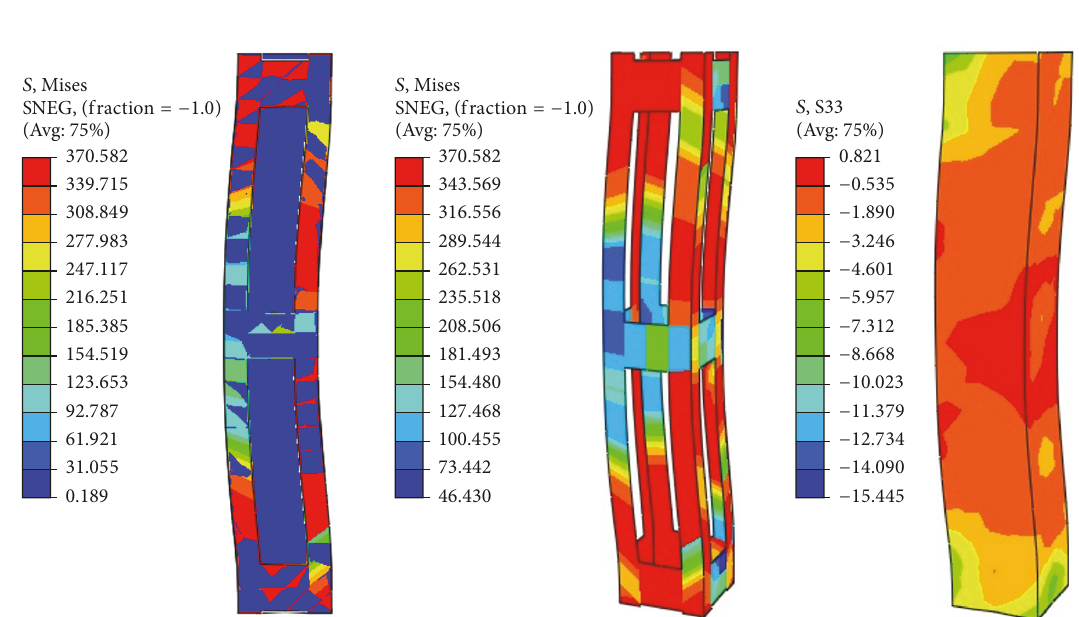
Figure 16: Bending stress in Col-0.